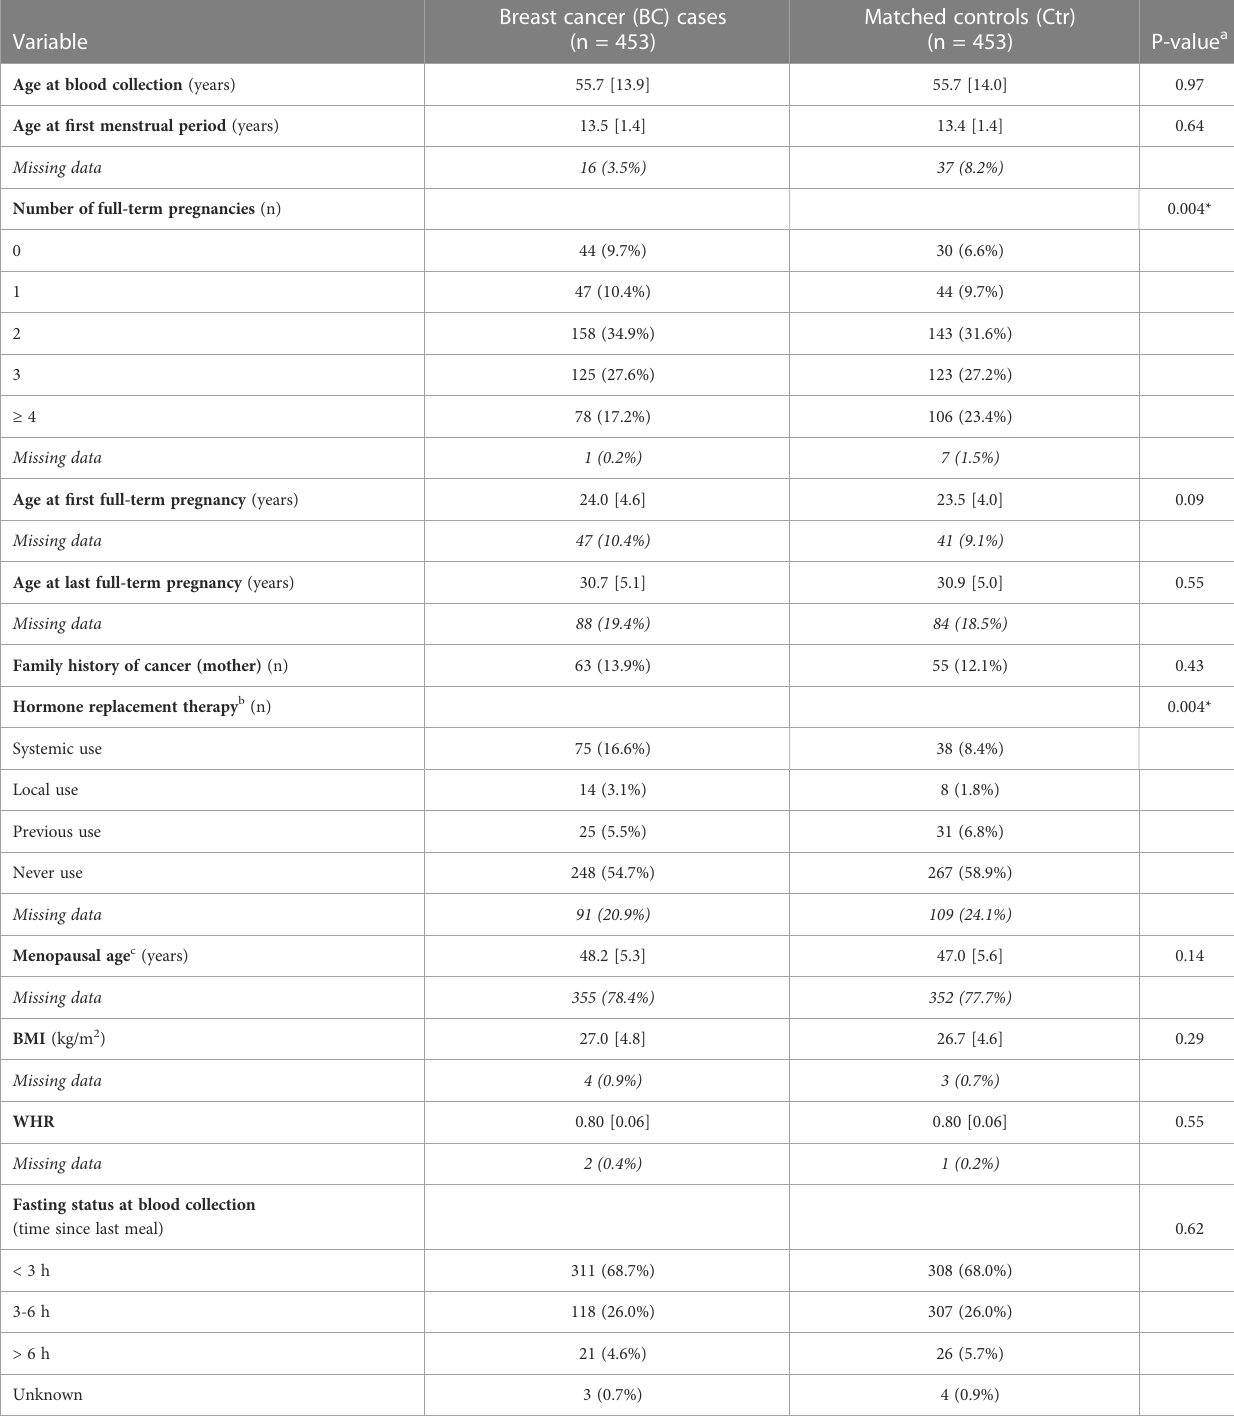
TABLE 1 Baseline characteristics for the study